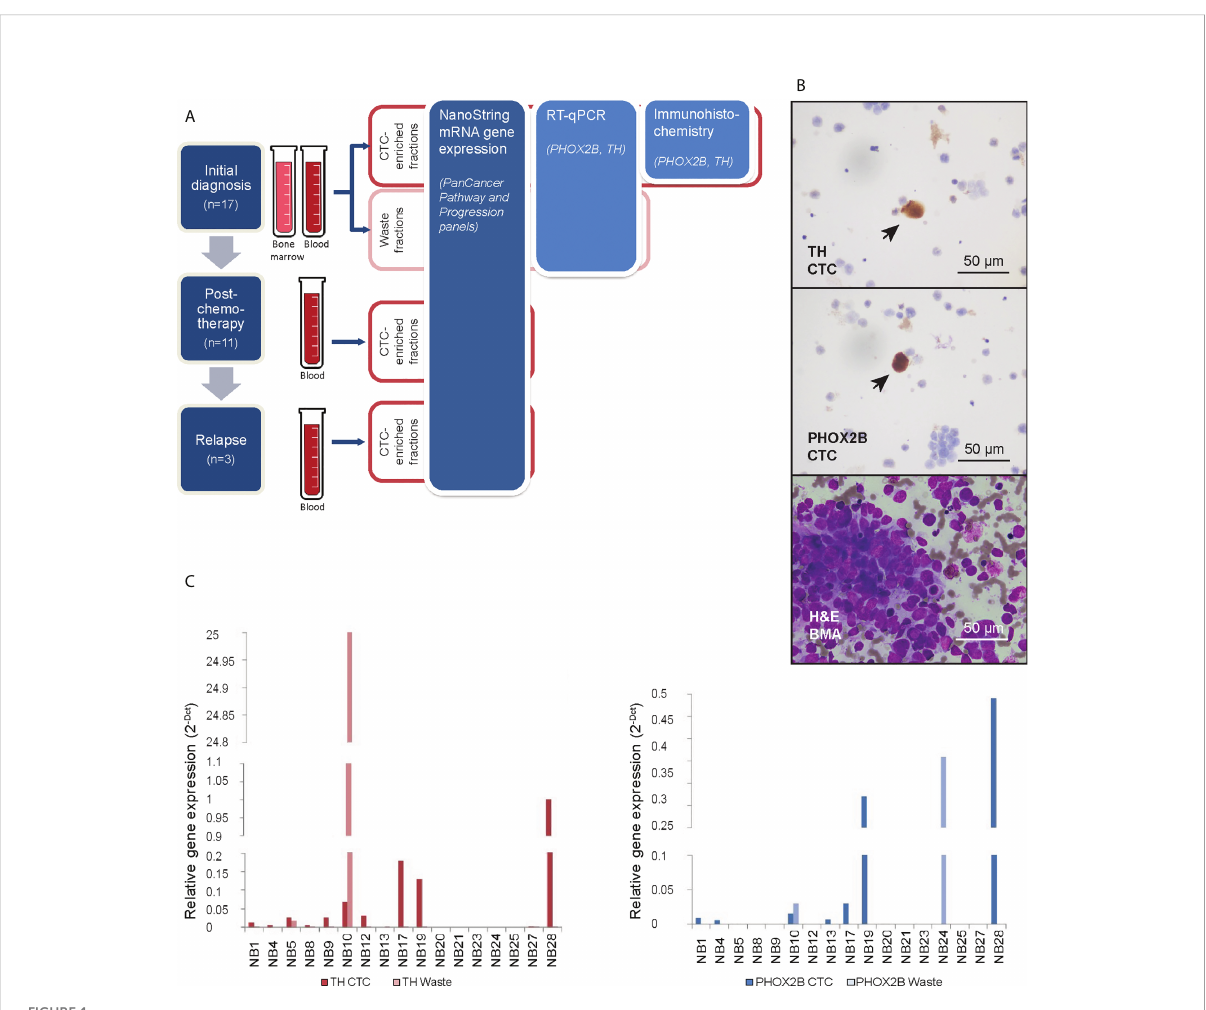
FIGURE 1 Neuroblastoma CTCs expressing characteristic markers are isolated using cell size-based separation. (A) Schema of experimental design and 3 serial timepoints where blood and/or bone marrow samples were obtained from patients for CTC enrichment. (B) Representative photomicrographs of cytospots of CTC-enriched fractions demonstrating PHOX2B- and TH-positivity of isolated large, atypical cells on immunohistochemical staining (arrows; NBL20 at initial diagnosis and NBL10 following induction chemotherapy, respectively; scale bar: 50 µm), and corresponding bone marrow aspirate with neuroblastoma tumor cell in fi ltration for size comparison (NBL20 at initial diagnosis; H&E, scale bar: 50 µm). (C) Relative gene expression of PHOX2B and TH in CTC-enriched and waste fractions from blood samples taken at